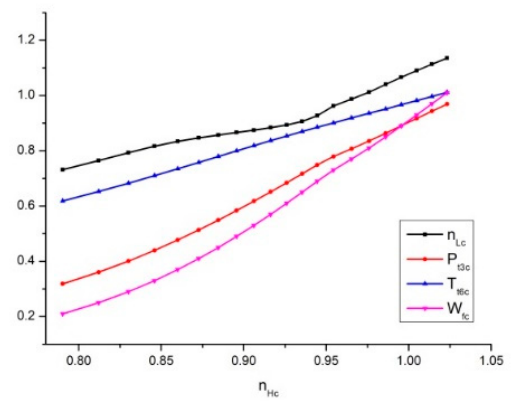
Figure 12. Schematic diagram of the relationship between the operating parameter and the steady-state parameters of the aero-engine.